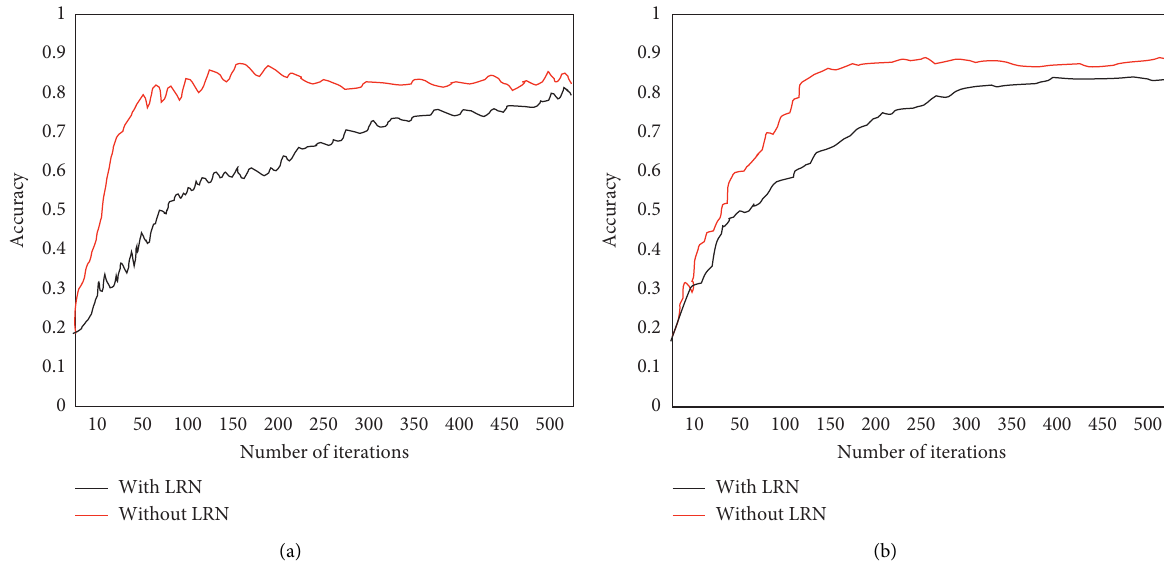
Figure 5: Accuracy change curve of test sample with number of iterations. (a) Accuracy in HMDB51 dataset. (b) Accuracy in UCF-101 dataset.